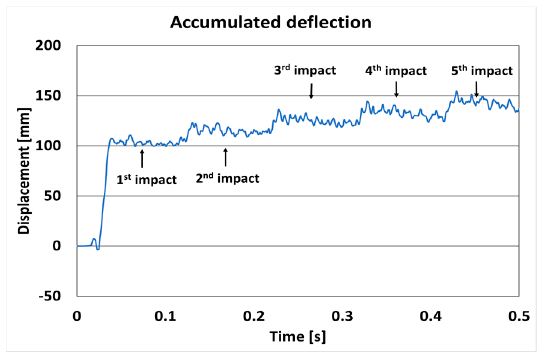
Figure 18. Accumulated deflection result for simulation.